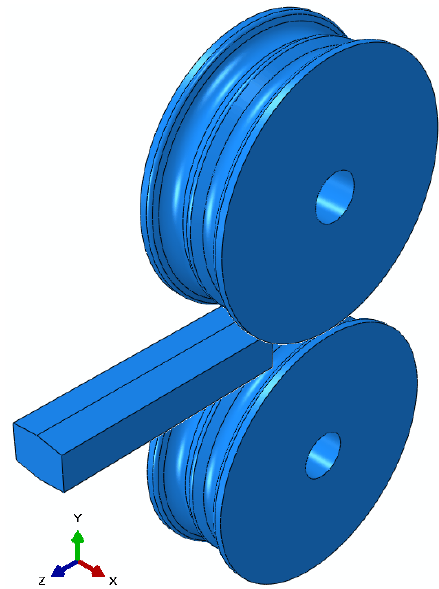
Figure 6. Finite element model of first slit rolling stage.